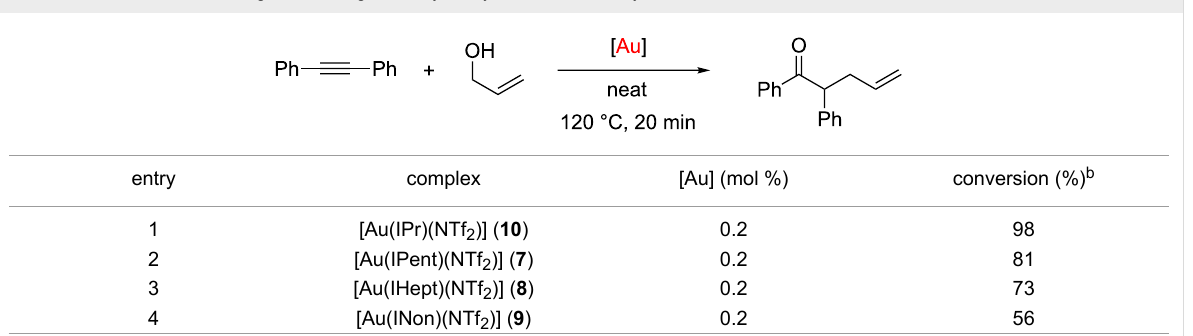
Table 3: Influence of the ITent ligands in the gold-catalysed synthesis of homoallylic ketones. a